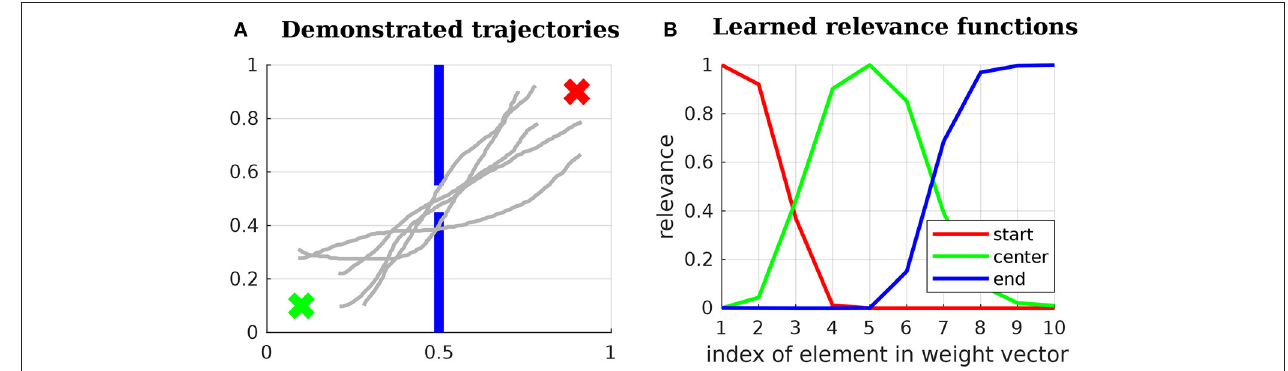
FIGURE 6 | (A) 2D problem used to explain the proposed Relevance Weighted Policy Optimization (RWPO) algorithm. The green x at the lower left corner of the image represents the start position. The blue lines in the middle represent a wall with a window in the center. The red x at the upper-right corner represents the end position. The goal of our algorithm is, given a few initial trajectories (depicted in light gray), to find a distribution over trajectories that begin at the start position, pass through the center of the window and reach the end position. (B) Learned relevance functions for the 2D problem. The learned relevance functions show that policy parameters close to w 1 are more important for beginning at the start position, policy parameters around w 5 are more important to pass through the center of the window and policy parameters close to w 10 are more important to reach the end position.